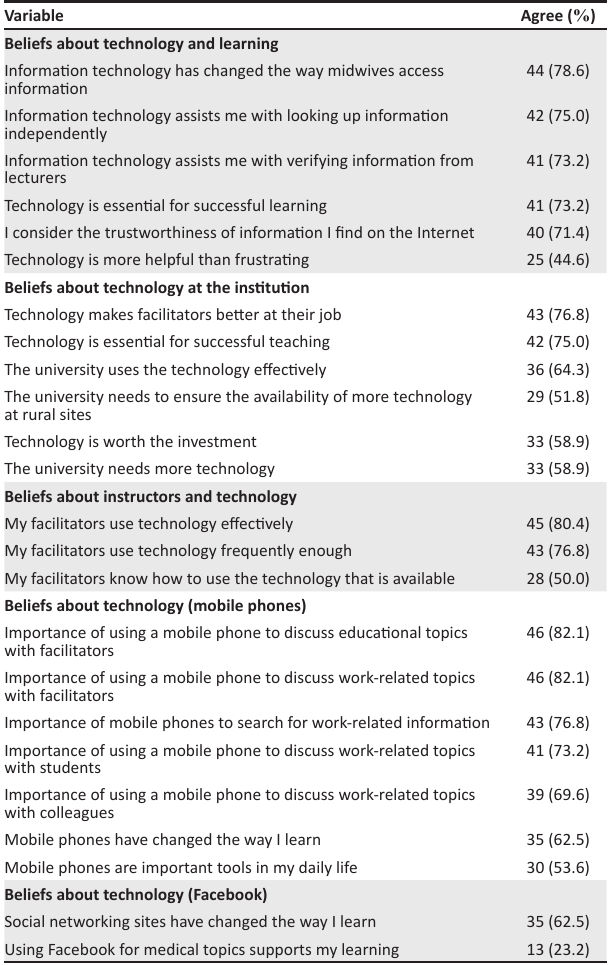
TABLE 5: Attitudes towards the use of technology and education ( N =